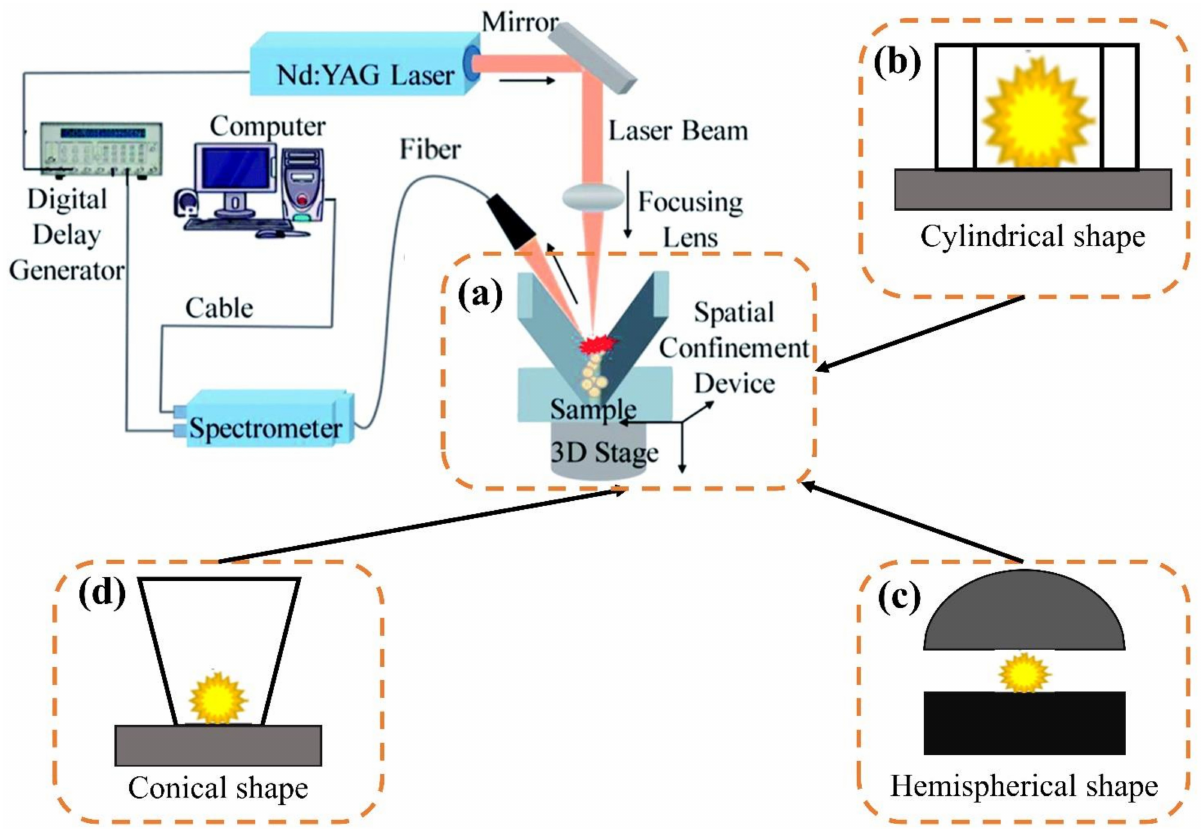
Figure 6. The spatial constraint-enhanced LIBS signal device. ( a ) V-shaped, ( b ) cylindrical shape, ( c ) hemispherical shape, ( d ) conical shape. Table 3. Adding auxiliary devices enhanced LIBS for heavy metal